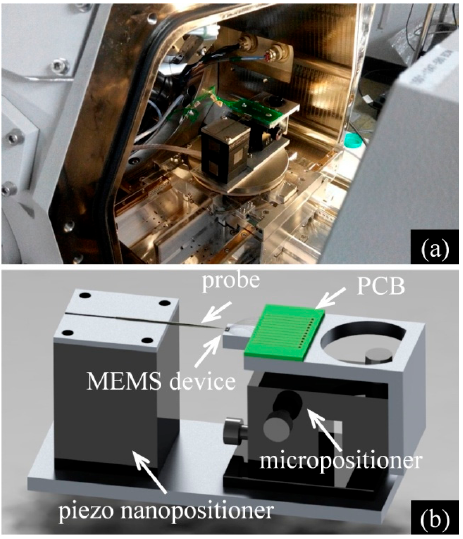
Figure 7. Setup for in situ tensile testing in SEM: ( a ) the optical image of the testing system equipped in SEM; and ( b ) schematic of the testing system.